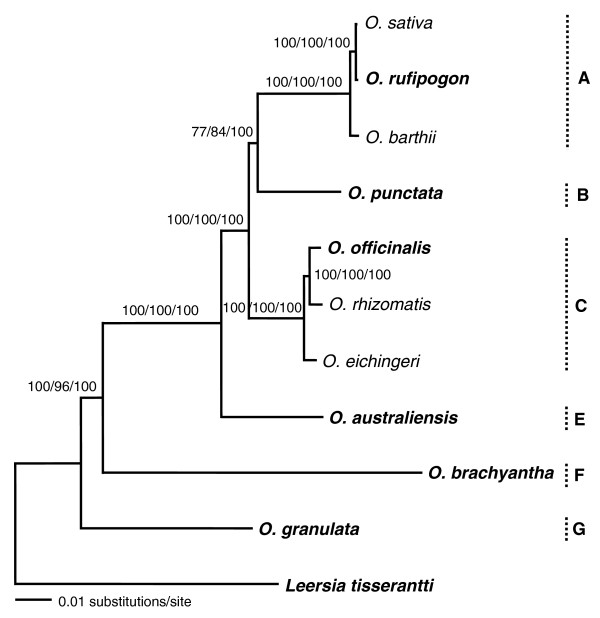
ML tree inferred based on concatenation of 62 genes from 11 species using the GTR+Γ model. Numbers above branches indicate bootstrap support of ML and MP, and posterior probability of BI analyses, respectively. Capital letters (A to G) beside the tree specify the genome type of the species. For the species in bold, 142 genes were sequenced and used in the analyses as shown in Figure 1.